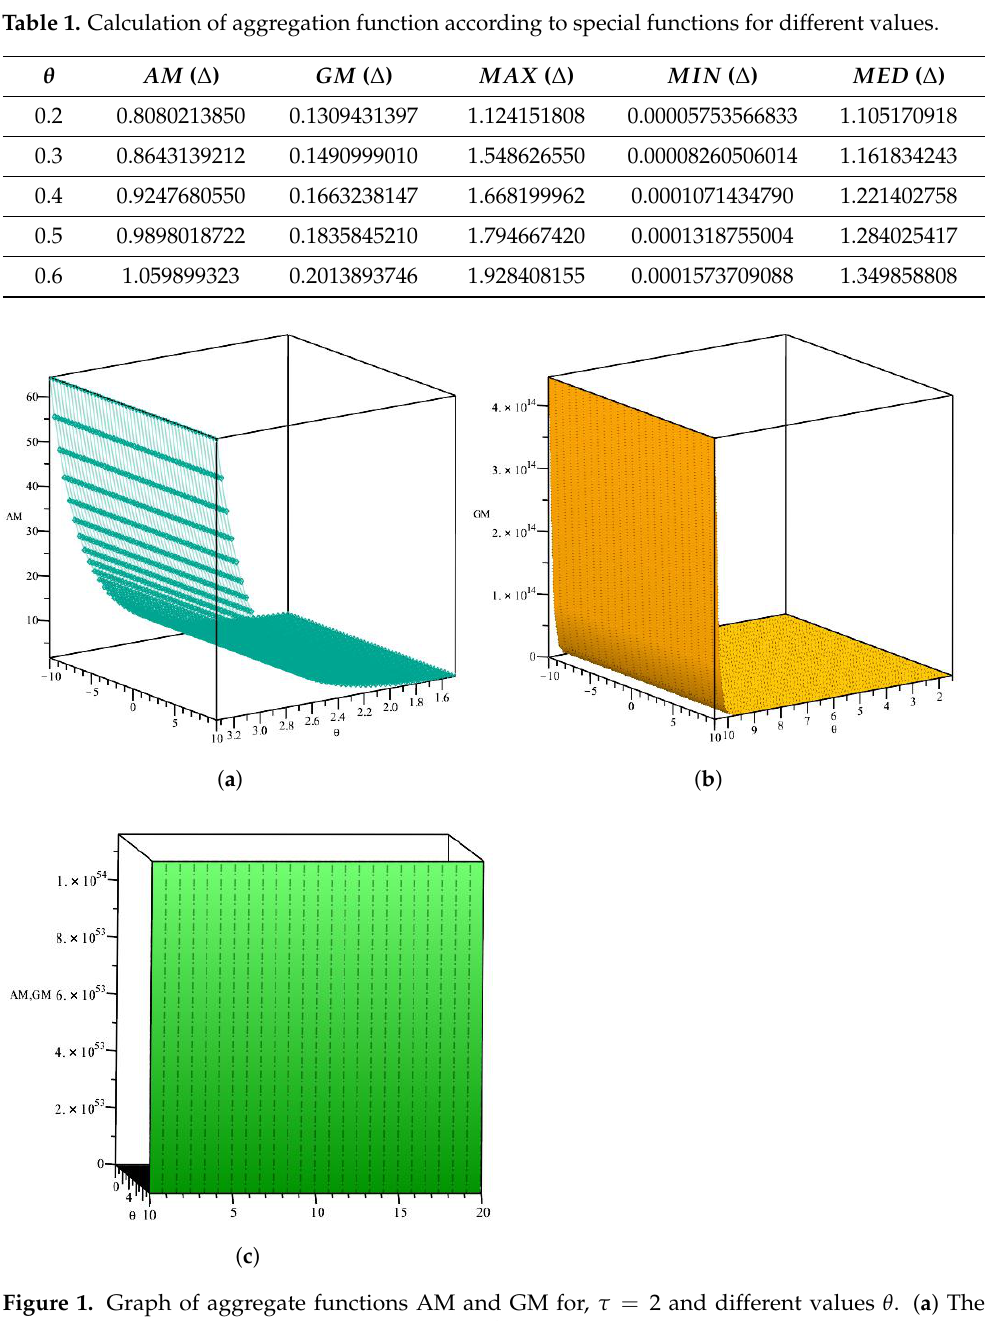
) . ( b ) The aggregation arithmetic mean function , 10 2 3